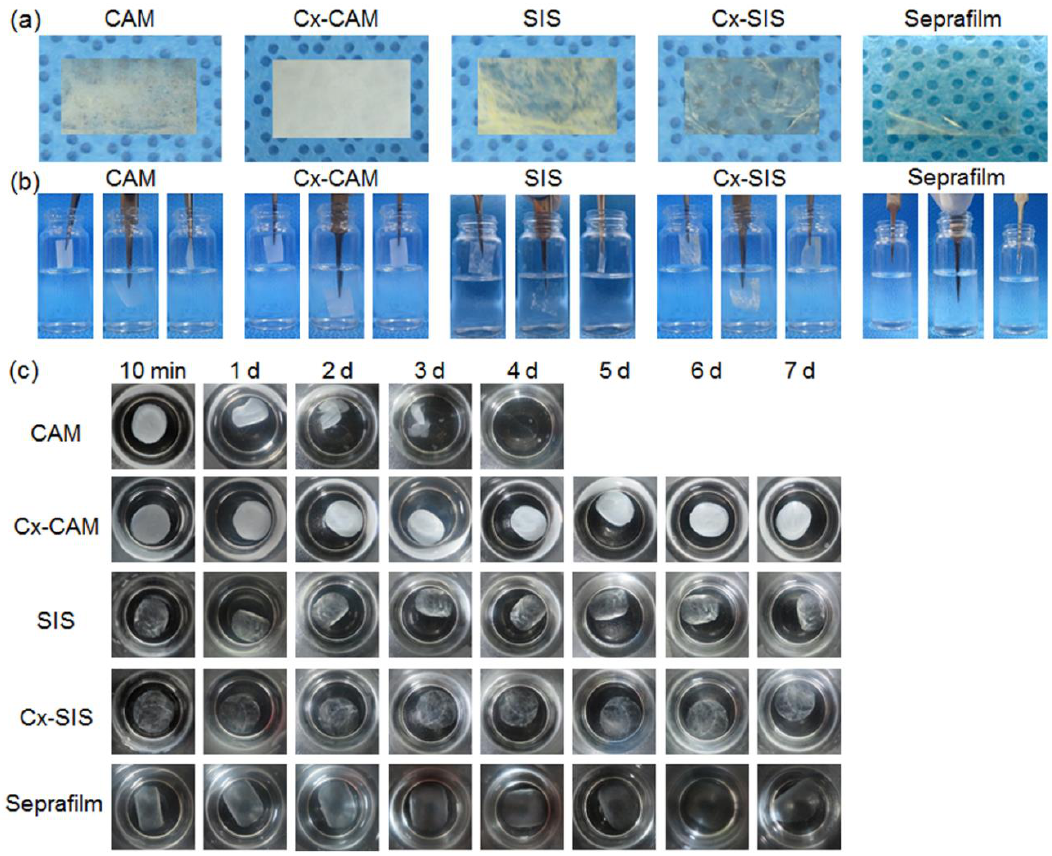
Figure 2. ( a ) Images of ( b ) side and ( c ) top views of CAM, cross-linked CAM (Cx-CAM), small intestinal submucosa (SIS), cross-linked SIS (Cx-SIS) films and Seprafilm before and after incubation in a vial with PBS.